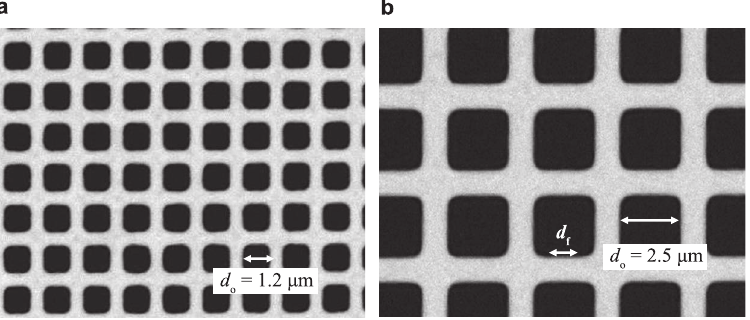
Fig. 6 Shapes of metal screens.